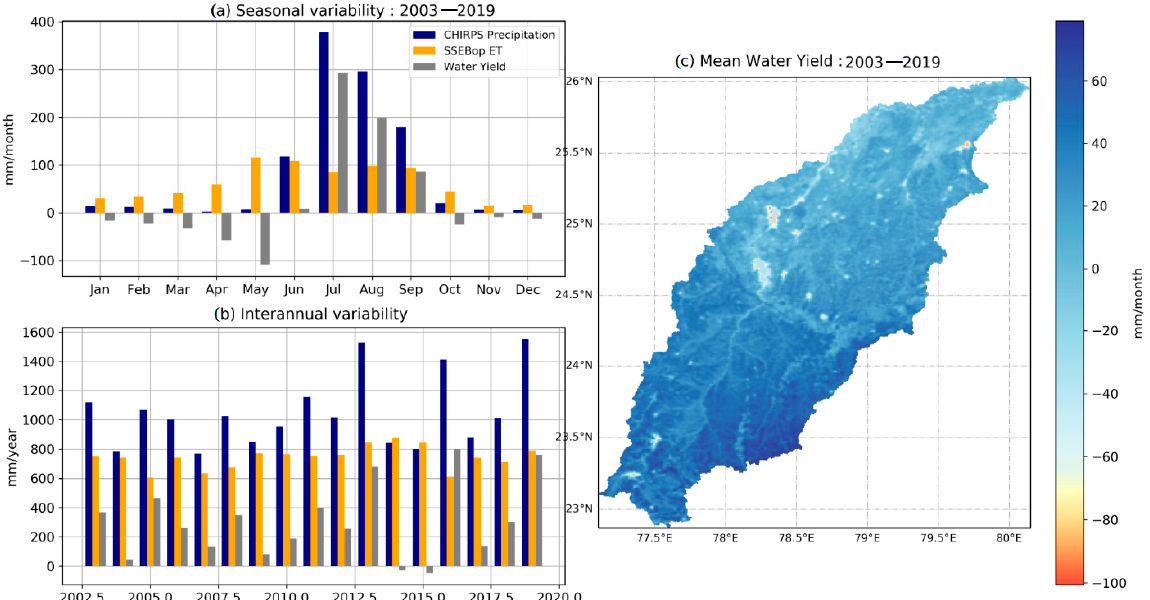
Figure 10. The figure shows the seasonal and inter-annual variability in the precipitation, SSEBop ET, and water yield obtained from the CHIRPS precipitation for the period of 2003–2019. ( a ) CHIRSP precipitation, SSEBopET and water yield seasonal and inter-annual variability in the pre- cipitation, SSEBop ET, and water yield; ( b ) inter-annual variability in the precipitation, SSEBop ET, and water yield; ( c ) mean water yield of period 2003–2019.